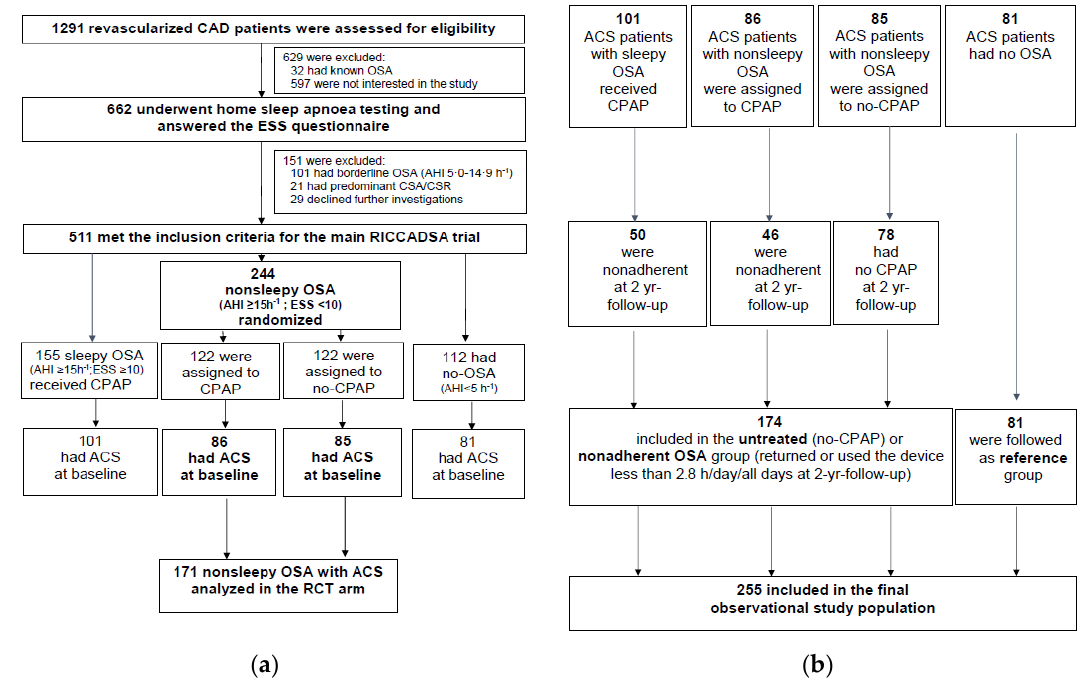
Figure 1. Flow of patients through the study: ( a ) The randomized controlled arm; ( b ) The final observational arm. Abbreviations : ACS, acute coronary syndrome; AHI, apnea-hypopnea index; CAD; coronary artery disease; CPAP, continuous positive airway pressure; CSA-CSR, central sleep apnea-Cheyne Stokes respiration; ESS, Epworth Sleepiness Scale; OSA, obstructive sleep apnea; RICCADSA, Randomized Intervention with CPAP in Coronary Artery Disease and Sleep Apnea.